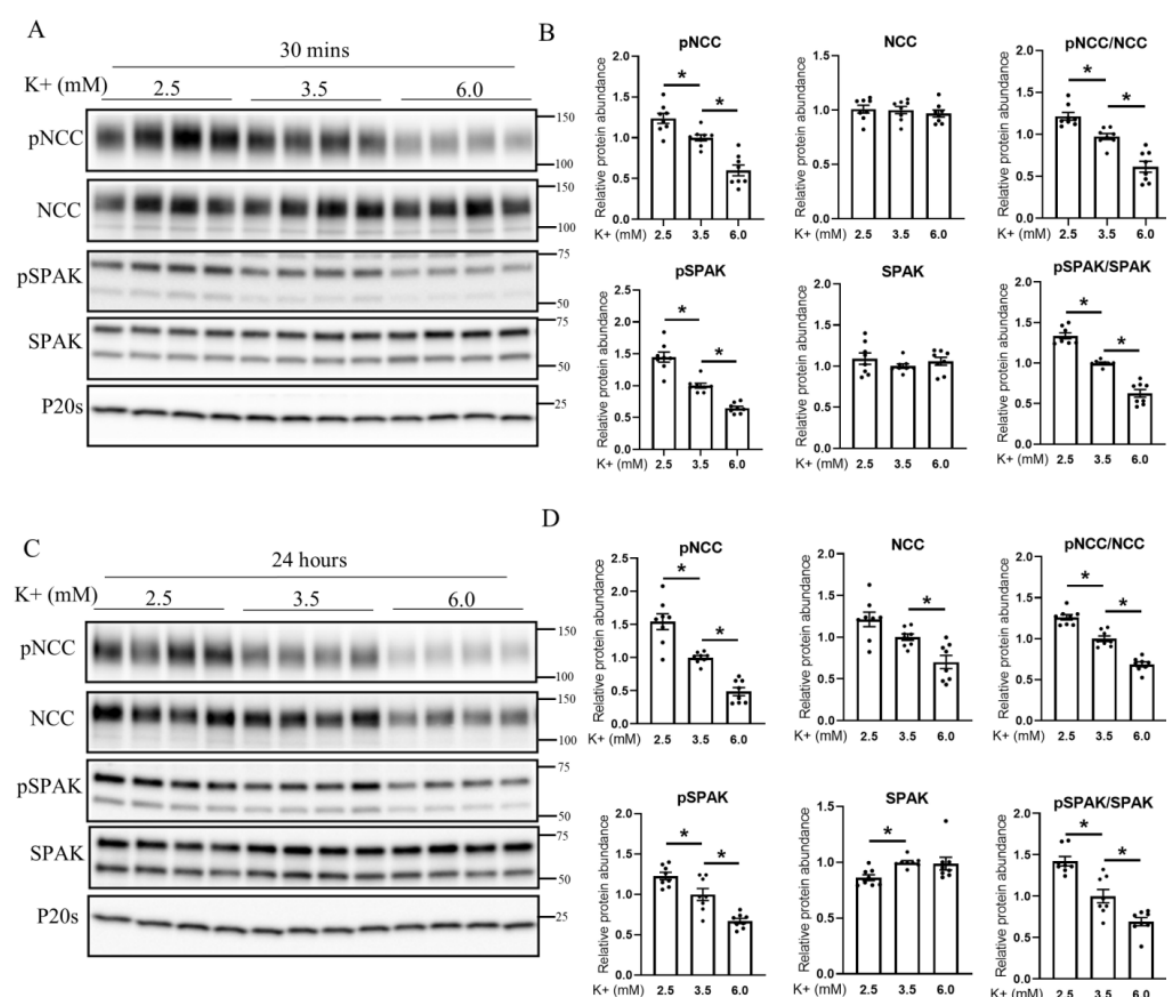
Figure 4. Extracellular K + concentration regulates NCC phosphorylation in isolated renal tubules. ( A ) Representative immunoblots of pNCC, NCC, pSPAK, SPAK, and P20s in isolated renal tubules that were incubated in the media containing either 2.5, 3.5, or 6 mM K + for 30 min ex vivo. Molecular weight markers (kDa) are shown on the right. ( B ) Summarized relative protein abundance data. ( C ) Representative immunoblots of pNCC, NCC, pSPAK, SPAK, and P20s in isolated renal tubules that were incubated in the media containing either 2.5, 3.5, or 6 mM K + for 24 h ex vivo and ( D ) summarized relative protein abundance data. In panels with graphs, each dot represents value from an individual well of independent tubules and each bar represents mean ± SEM obtained from two independent experiments ( n = 8). * indicates p < 0.05 relative to 3.5 mM